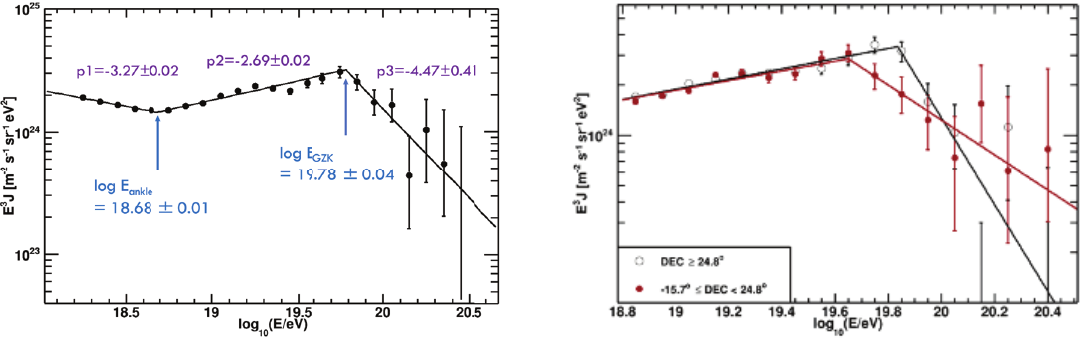
Figure 3. Energy spectrum using 14-year SD data and declination dependence. (Left) The data is represented with the black points with error bars, and a fit to the broken power law is shown with the black solid line. Here, we fit to the broken power law having two breakpoints, where p1, p2 are the spectral indices before and after the ankle, respectively, E ankle is the energy of the ankle, ff , and p3 is the spectral index after the GZK cuto ff . (Right) The data in the lower declination E GZK is the energy of the GZK cuto ( − 15 . 7 ◦ ≤ δ < 24 . 8 ◦ ) are marked with the red dots overlaid with the red fitting line. The data in the higher declination ( δ ≥ 24 . 8 ◦ ) and its fitting result are shown with the open black circles superimposed and the black line, respectively.